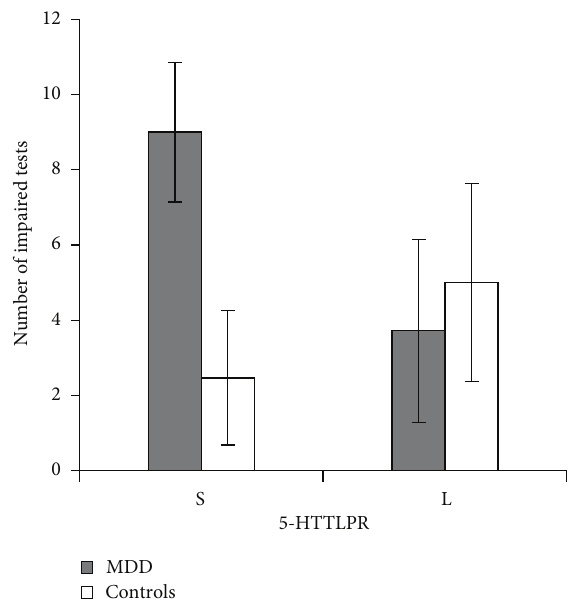
F 1: Number of impaired neuropsychological test perfor- mances in major depressive disorder (MDD) patients and controls carrying the S variant and the L variant of the